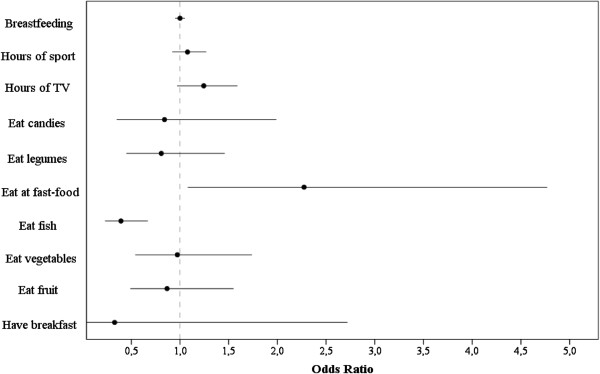
Obesity prevalence risk factors. These risk factors are listed in order of appearance in the questionnaires: breastfeeding, sporting activity time, hours watching television (TV) or video games, sweetened snacks and beverages, consumption of legumes, fast-food, fish, vegetables, fruit and having breakfast. The results showed that eating fish is a protector against childhood obesity while eating fast-food is a risk factor. These risk factors are measured as odds ratios.